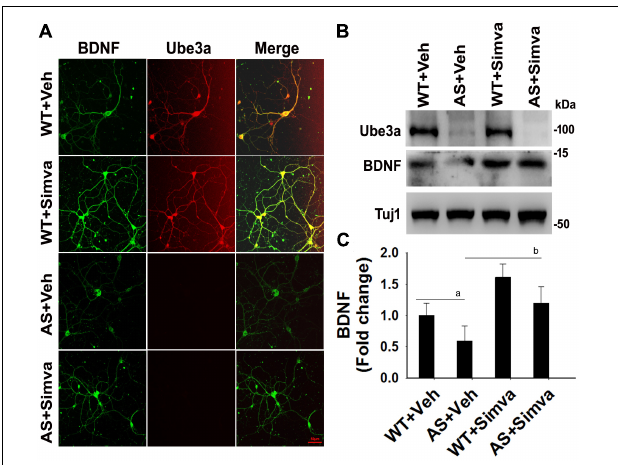
FIGURE 9 | Simvastatin treatment increases BDNF expression in primary cortical neurons of AS mice. (A) Primary cultured cortical neurons prepared from wild type and AS embryos were treated with 5 µ M simvastatin at DIV14 for 12 h. Neurons were then fixed and processed for double immunofluorescence staining using Ube3a and BDNF antibodies. Representative images were shown. About 12 immunostained neurons in each group were checked for BDNF expression, fluorescence intensity in each cell was quantified and compared. Scale bar, 50 µ m. (B) Immunoblot analysis of matured BDNF levels in simvastatin treated primary cortical neurons as described above. (C) Band intensity of the mature BDNF was quantified and normalized to Tuj1 (BDNF/Tuj1). Values are mean ± SD; n = 3. The ‘a’ point P < 0.05 compared to vehicle treated wild type group and “b” denote P < 0.05 with respect to vehicle treated AS group (one way ANOVA with Holm–Sidak post hoc